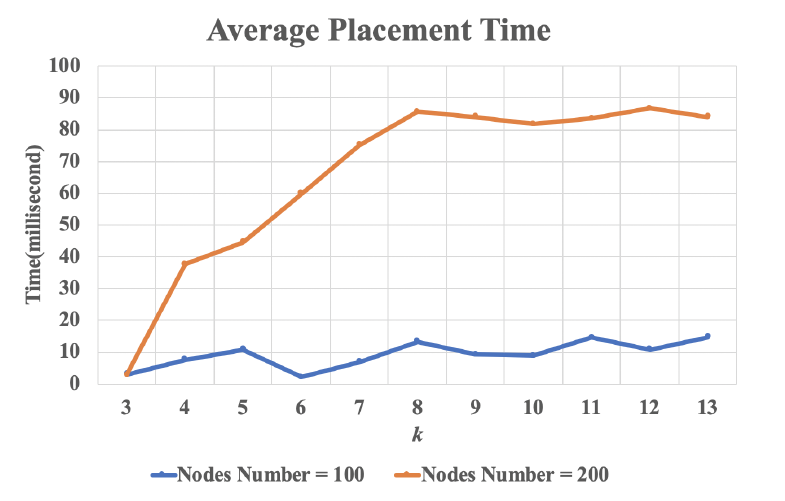
Figure 11. The result of the average placement time with different k